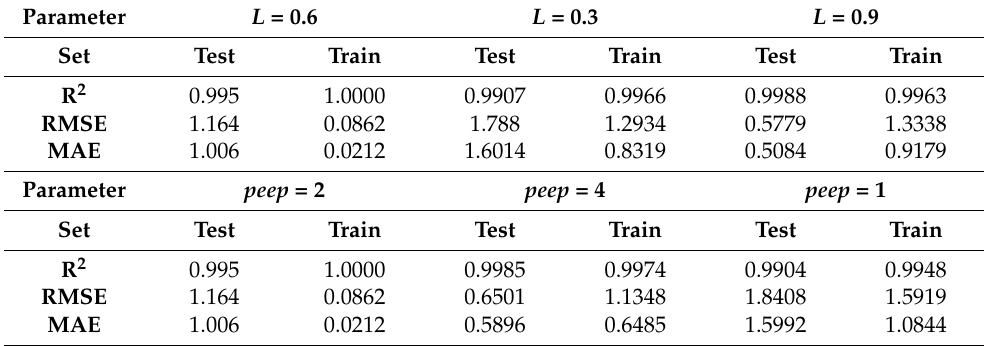
Table 2. Influence of changing the parameters of